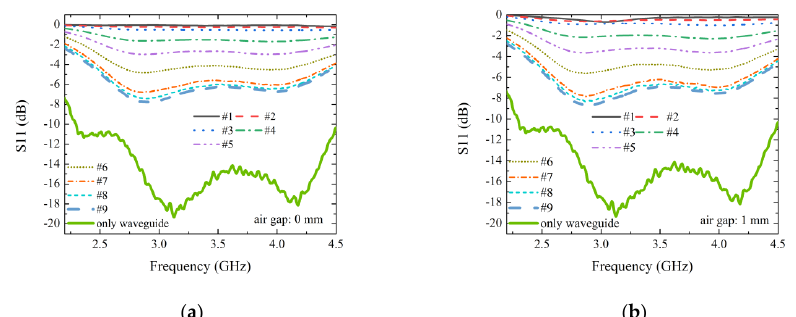
Figure 4. Measured normalized reflection coefficient (S 11 ) for all of the samples with glass thickness 1.1 mm: ( a ) without air gap; ( b ) with 1 mm air gap.